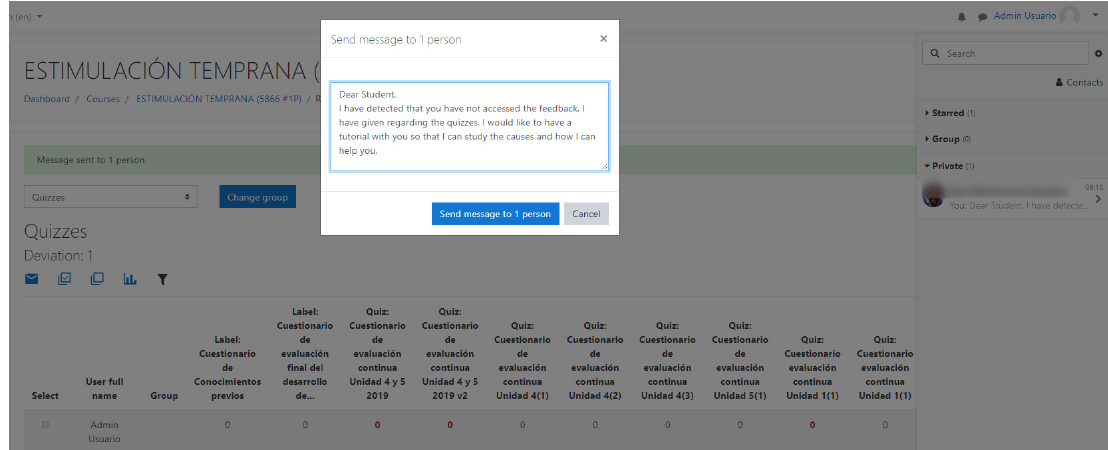
Figure 7. Functionality of sending a message to facilitate the orientation of the at-risk student.